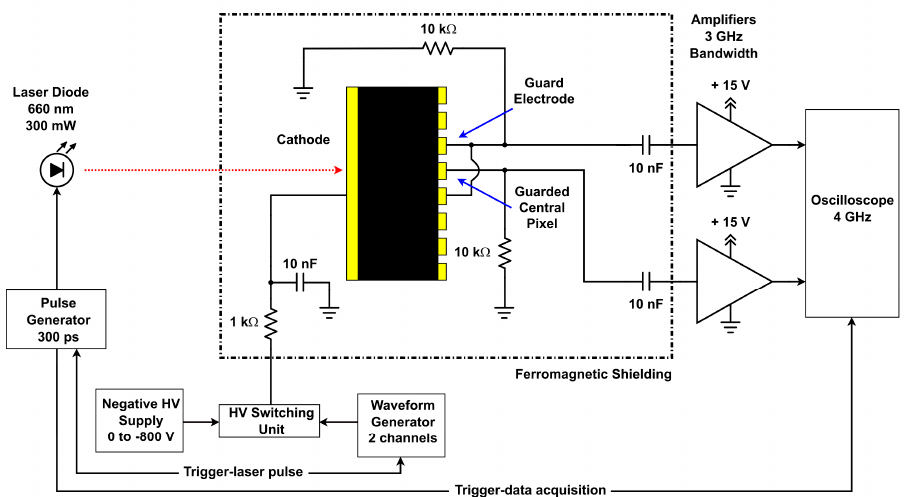
Figure 2. Block diagram of L-TCT setup for measuring transient currents.